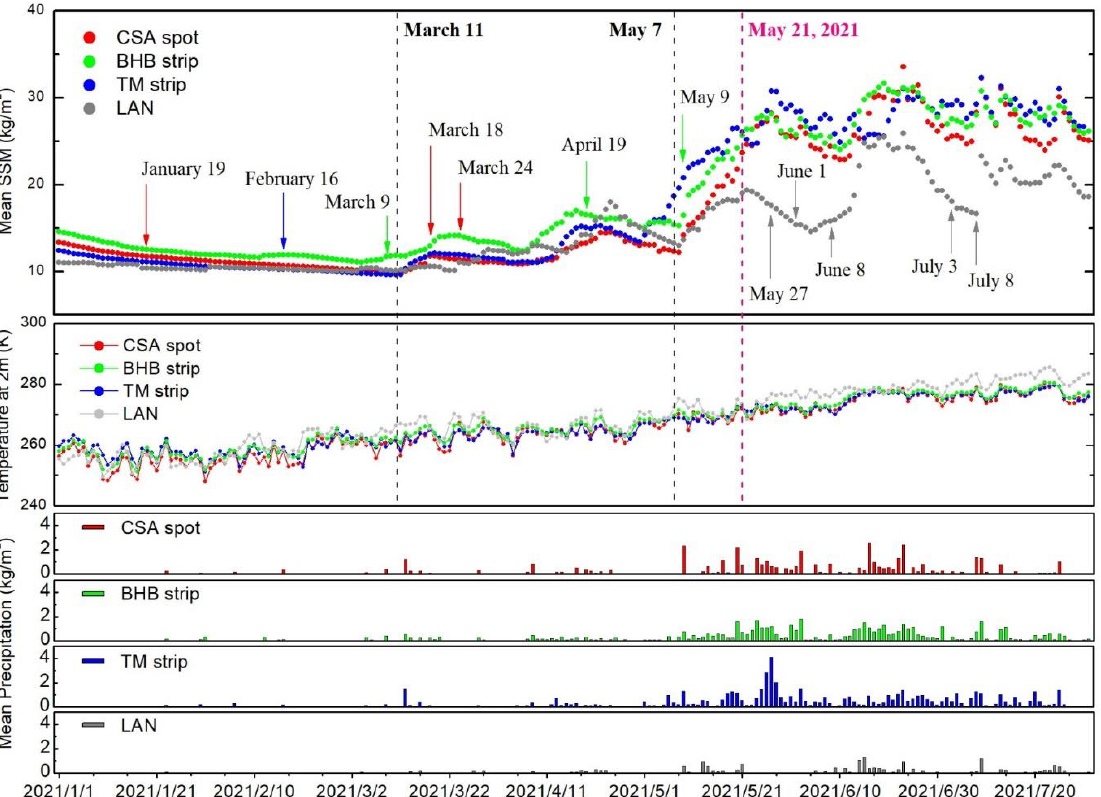
Figure 6. The variations of surface soil moisture, air temperature and precipitation in four characteristic abnormal regions from January to July, 2021. Several dates of the typical MBT residuals are indicated by arrows in the figure.